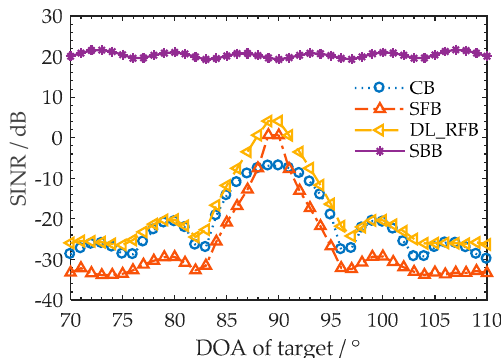
Figure 11. Output SINR versus DOA of target.